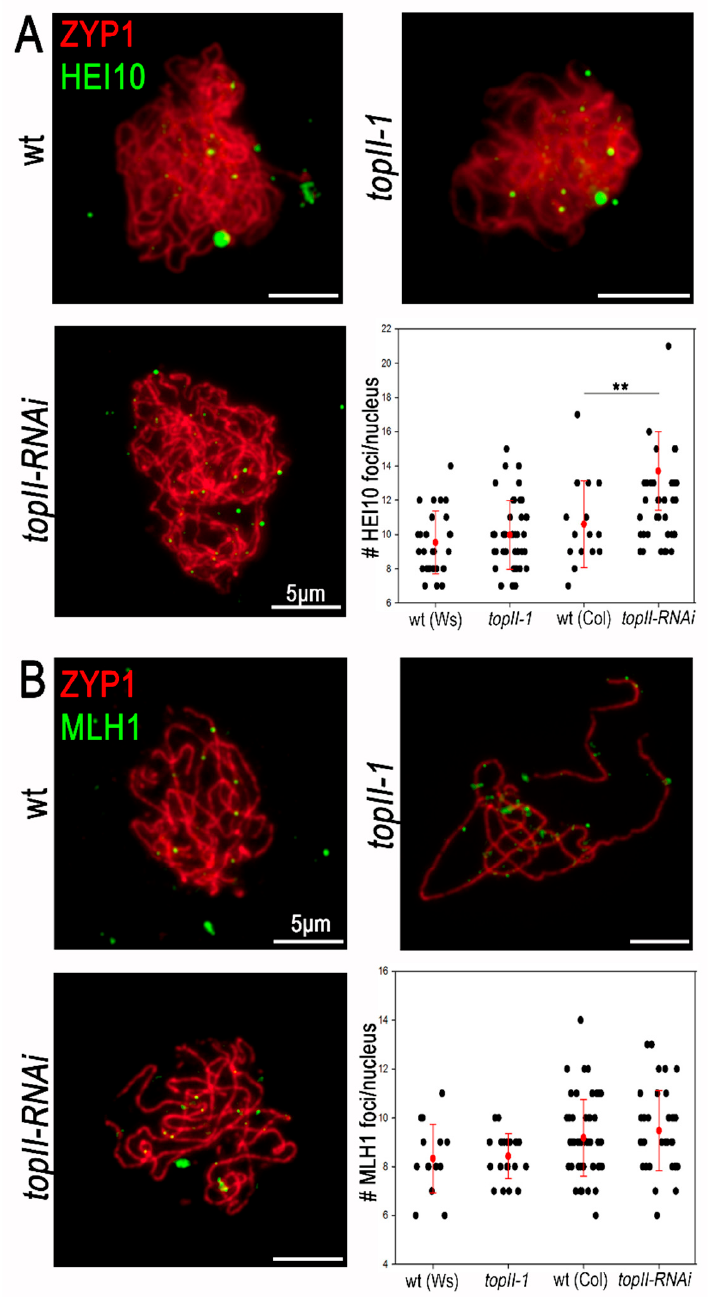
Figure 4. Meiotic CO designation and maturation appears normal in topII plants. ( A ) HEI10 (green) and ASY1 (red) staining of wt, topII-1 and topII-RNAi zygotene cells and HEI10 foci distribution per cell. ( B ) MLH1 (green) and ZYP1 (red) staining of wt, topII-1 and topII-RNAi pachytene cells and MLH1 foci distribution per cell. Bars: mean ± standard deviation. Mann–Whitney U-test, p -value: **